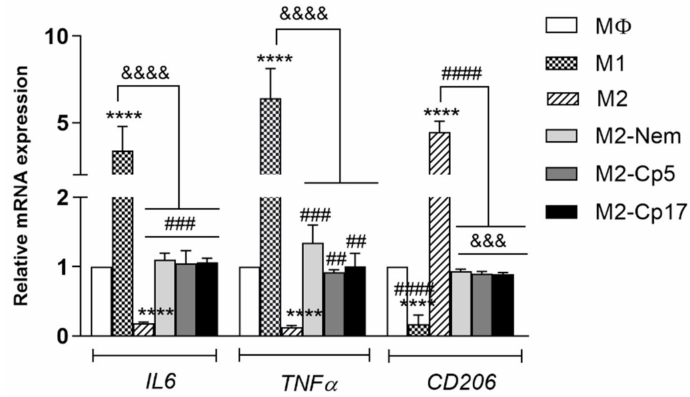
Figure 3. E ff ect of Nem and Cp on M2 repolarization. mRNA levels of IL6, TNF α and CD206 after exposure to 21 µ M, 44 µ g / mL, 16 µ g / mL of Nem, Cp5 and, Cp17, respectively. Data reported as the mean ± SD of three independent experiments. **** p < 0.0001 vs. M Φ , &&& p < 0.001, &&&& p < 0.0001 vs. M1-like macrophages and ## p < 0.01, ### p < 0.001, #### p < 0.0001 vs. M2-like